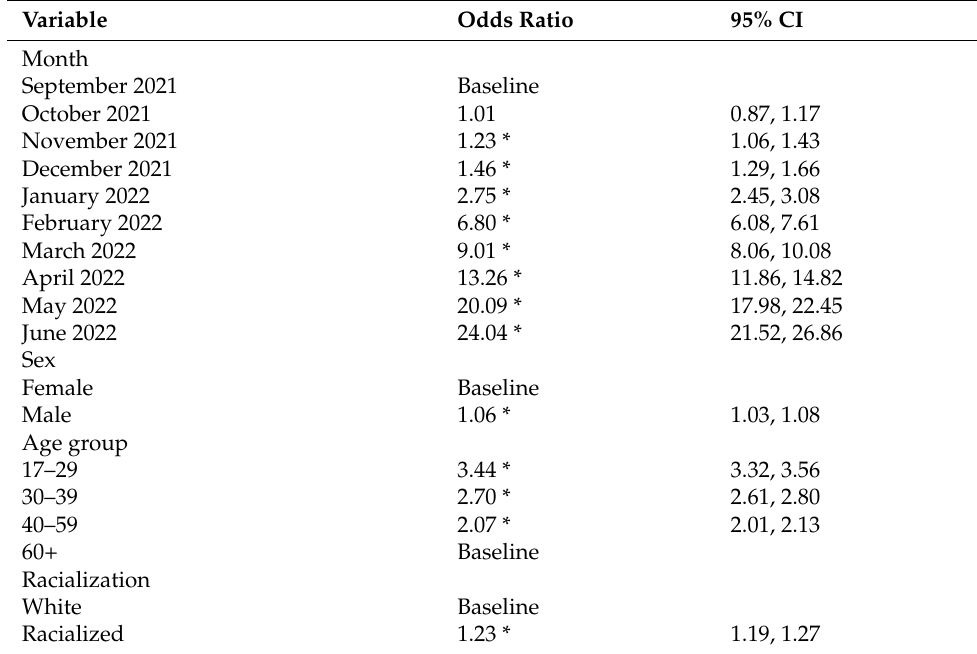
Table A4. Multivariable logistic regression model with anti-N positive as the dependent